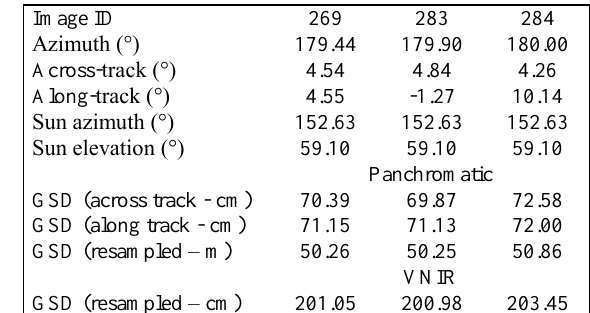
Table 1. Main characteristics of used images.